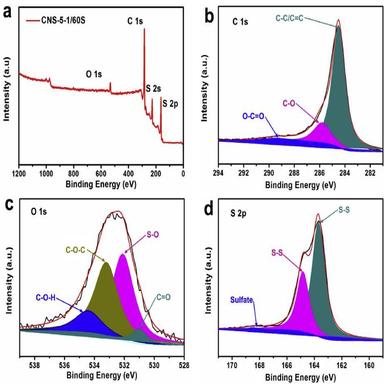
a) Overall XPS spectra of CNS-5-1/60S. b), c) and d) are matched XPS spectra of C 1s, O 1s and S 2p, respectively. (A colour version of this figure can be viewed online.)